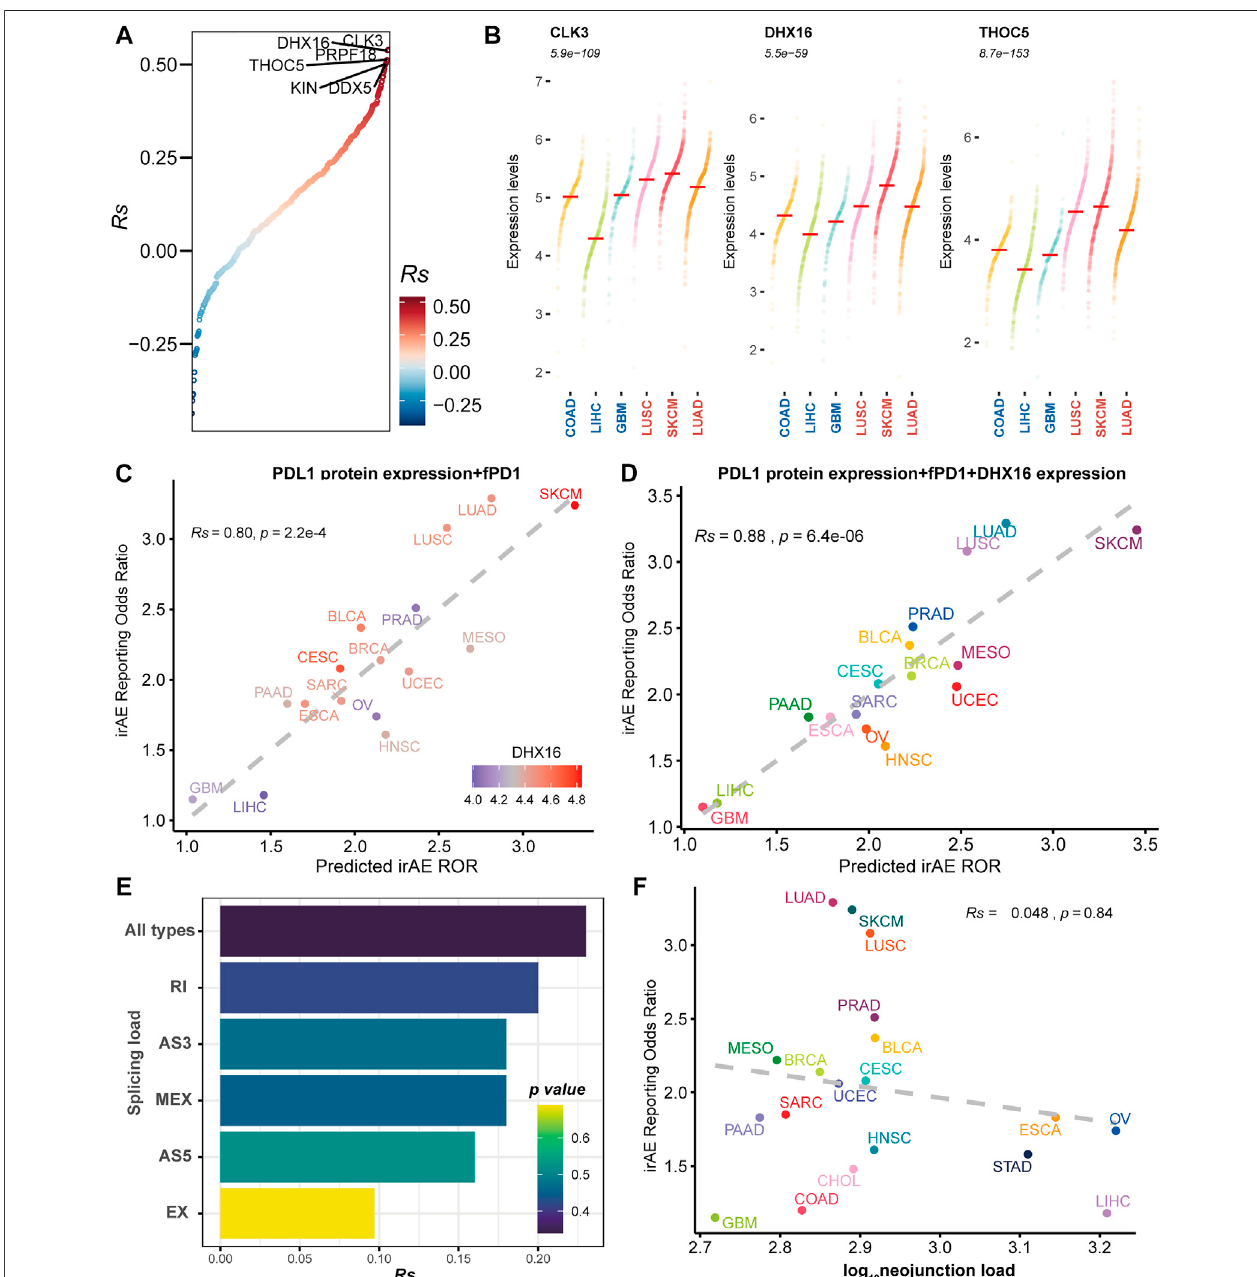
FIGURE 1 | The association between irAE and alternative splicing characteristics. (A) Spearman correlation between splicing factor expression and irAE ROR. All splicingfactorsareorderedbycorrelationswithirAEROR.Thesplicingfactorswith Rs > 0.5arelabeled byname. (B) Expressiondistribution ofthetopthreesigni fi cantly irAE correlated splicing factors in high- and low-irAE ROR cancer types, including CLK3 , DHX16 , and THOC5 . Each dot represents log 2 (TPM+0.001) transformed expression levelofeachsplicingfactorinasinglesample.Themedianoftheexpressionlevelofeachsplicingfactorforeachcancertypeisindicatedbyahorizontal redline.TheWilcox-test p value,comparingthedifferenceofexpression levelsbetweenhigh-andlow-irAERORgroups,isdelineated atthetop. (C) Combinedeffectof PD-L1 protein expression + the fraction of high PD-1 messenger RNA expression samples (fPD1) bivariate model ( Rs (cid:1) 0.80, p (cid:1) 2.2e-04). The dashed line represents thelinear fi t.Spearman ’ scorrelationcoef fi cient ( Rs )wascalculatedbetweenpredicted and observedirAEROR. Rs and thecorresponding p valueareshown at thetop- left of the fi gure. The regression formula for irAE ROR is − 1.80 × PD-L1 protein expression +3.97 × fPD1 + 1.73. DHX16 expression in each cancer type is color-coded. (D) Combined effect of PD-L1 protein expression + fPD1 + DHX16 expression trivariate model ( Rs (cid:1) 0.88; p (cid:1) 6.4e-06). The regression formula for irAE ROR is − 1.77 × PD-L1 protein expression +2.87 × fPD1 + 0.83 × DHX16 expression − 1.74. (E) Spearman correlation between irAE ROR and splicing load of each splicing mode. The bar represents Rs , whereas the color indicates p value. (F) Spearman correlation between neojunction load and irAE ROR. The x -axis indicates the neojunction load across 19 cancer types, de fi ned as the median number of the total number of neojunction. AS3 alternative 3 ′ splice site, AS5 alternative 5 ′ splice site, EX exon skipping,